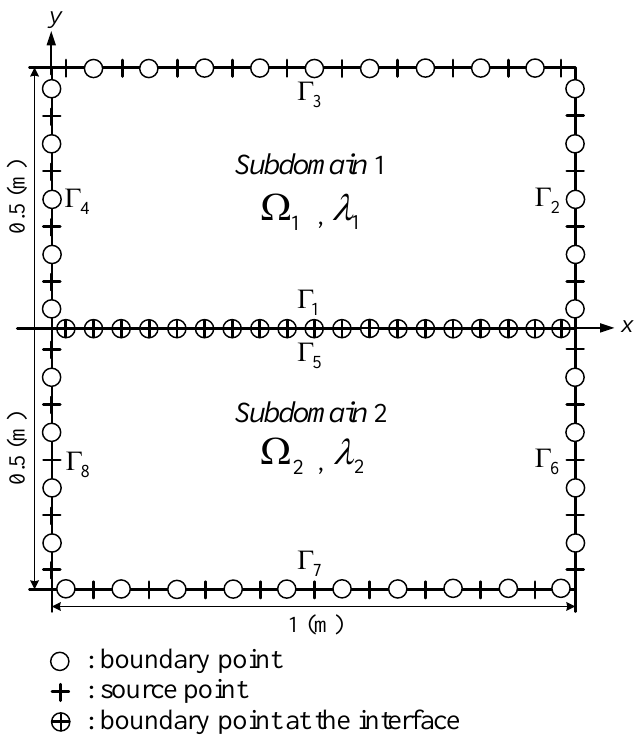
Figure 17. Boundary and source points for the example with two layered materials.